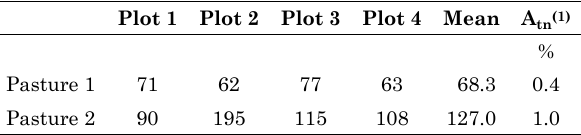
Table 1. Number of termite mounds in the plots and mean number of mounds per pasture on the